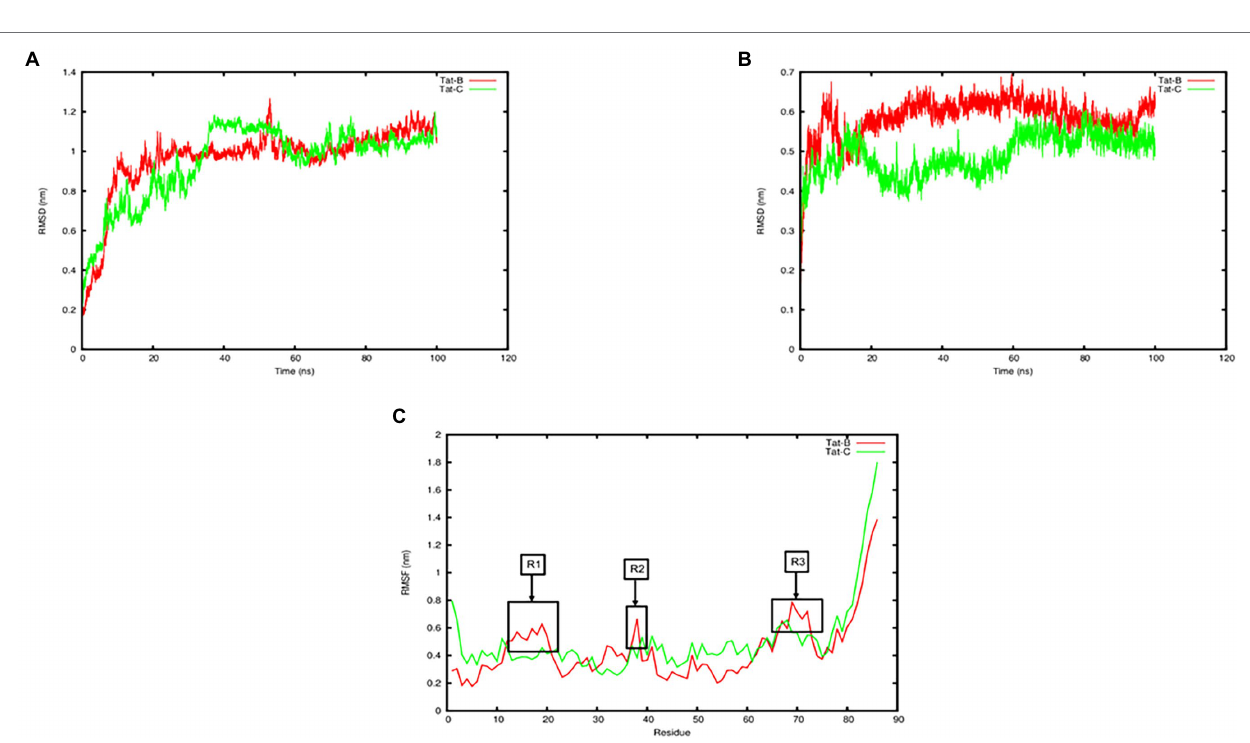
FIGURE 4 | Plot of molecular dynamic simulation trajectories of Tat subtype B and Tat subtype C interaction with TAR. (A) Tat subtype B-TAR and Tat subtype C-TAR systems on the backbone RMSD values over 100ns. (B) TAR element subtype B and TAR element subtype C systems heavy chain atoms RMSD values over 100ns. (C) Root mean square fluctuation (RMSF) of the protein residues between Tat subtype B-TAR and Tat subtype C-TAR. Highly flexible regions R1–R3 are labelled and shown in